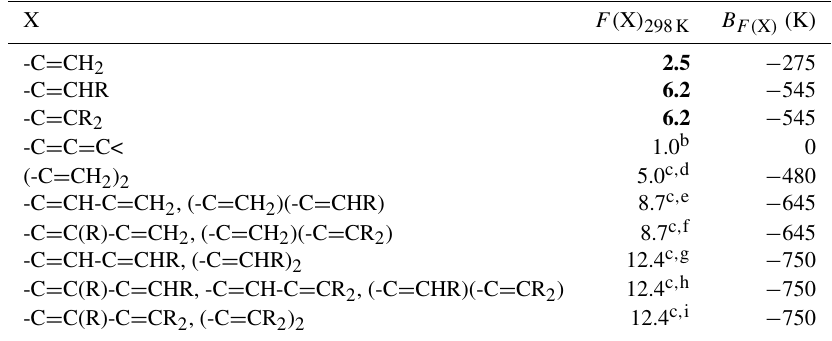
Table 12. Substituent factors F( X ) related to the H-atom abstraction reactions of OH adjacent to C = C bonds a , and their temperature dependences described by F( X ) = exp( − B F ( X )/T